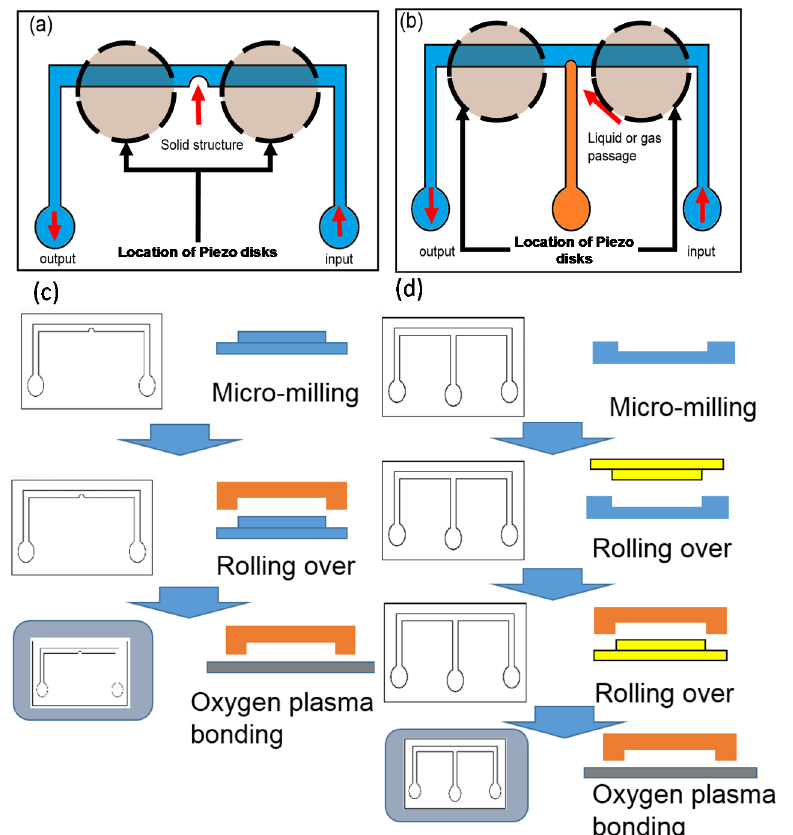
Figure 1. Manufacturing of the microchannel with obstructions to induce acoustic streaming in the current study: ( a ) design for the solid bulge obstruction; ( b ) design for the liquid droplet or gaseous bubble obstructions; ( c ) manufacturing process flow of design ( a ); ( d ) manufacturing process flow of design ( b ).